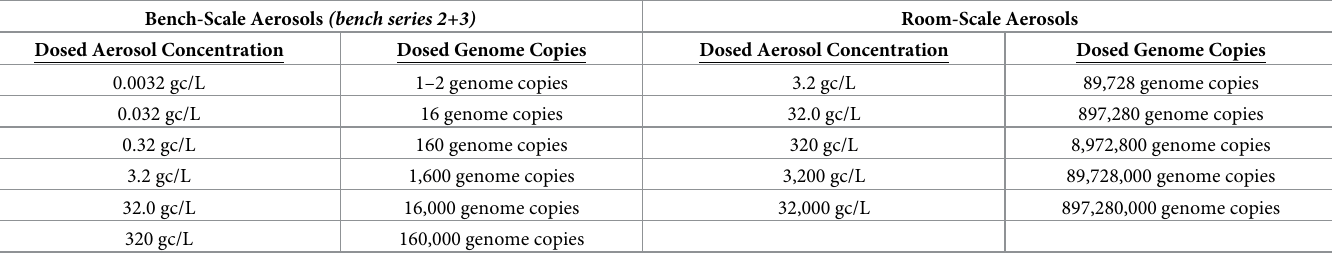
Table 1. Dosed aerosol concentrations and predicted total genomes aerosolized in bench-scale and room-scale aerosolization experiments. Bench-Scale Aerosols (bench series